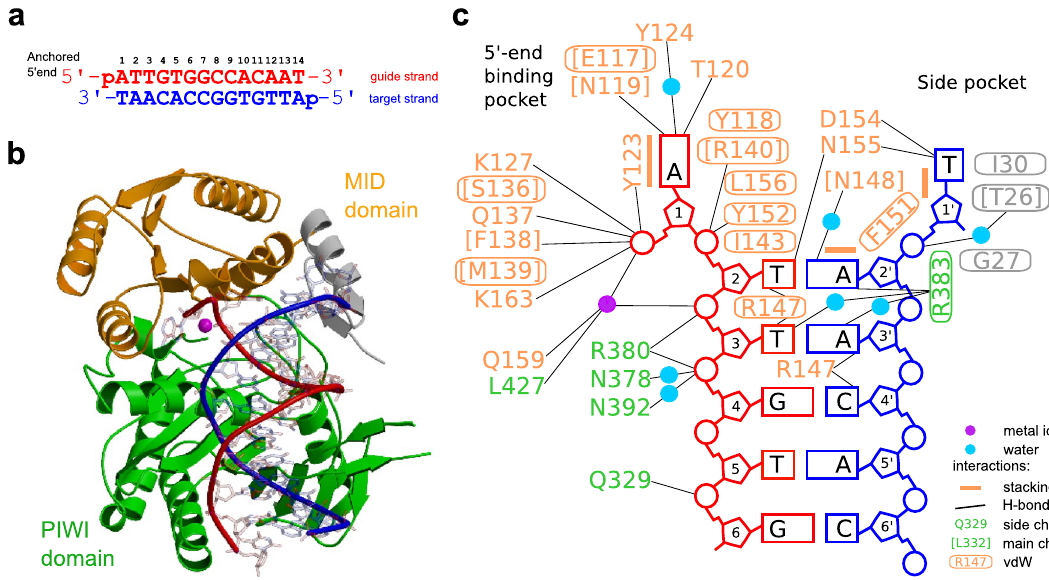
Figure 4. Structure of the AfAgo-DNA complex. ( a ) The 5 ′ -ATT DNA oligoduplex used for crystallization. ( b ) The overall structure of the AfAgo-DNA complex. The backbone of DNA strands is coloured as in A. DNA bases are transparent. The Mg 2+ ion involved in coordination of the 5 ′ -phosphate of the guide strand is shown as a magenta sphere. ( c ) Schematic representation of AfAgo contacts with the DNA.